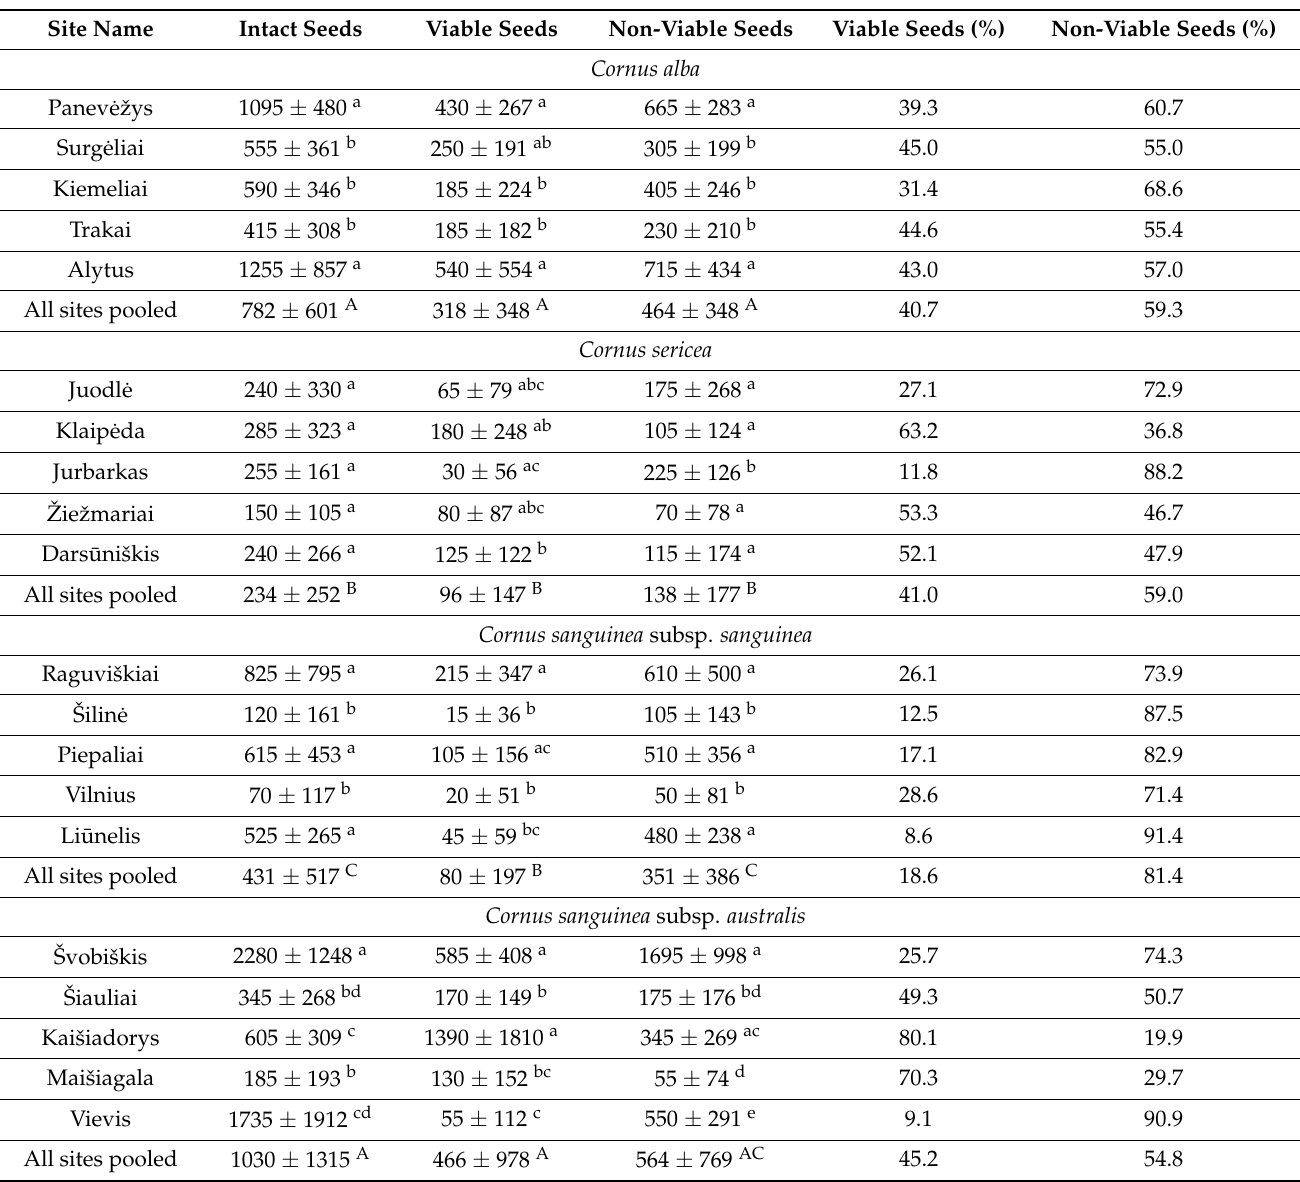
(Table 3). The density of intact seeds at all pooled C . alba sites was significantly higher than at C . sericea sites (Dunn’s z = 7.62, p < 0.001). The largest variation in the mean density of intact seeds in the upper soil layer was recorded at C . sanguinea subsp. australis sites. The density of intact seeds at Cornus sanguinea subsp. australis sites was significantly higher than the density of intact seeds at Cornus sanguinea subsp. sanguinea sites ( z = 4.11, p < 0.001). A significant difference in the intact seed density in the upper soil layer was found between all studied taxa by applying the Kruskal–Wallis H test (H = 75.35, p < 0.001). However, a pairwise comparison revealed no differences between C. alba and C . sanguinea subsp. australis sites ( z = 1.02, p = 0.306). Table 3. Mean density of intact, viable and non-viable seeds (mean ± SD) per 1 m − 2 and percentage of viable and non-viable seeds in the upper soil layer (0–5 cm) of individual sites and all sites pooled of the studied Cornus taxa. Different lower-case and capital letters denote statistically significant differences between the means among the sites and taxa, respectively, applying Dunn’s post hoc